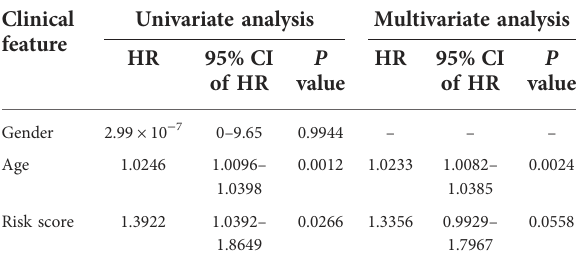
TABLE 4 Univariate and multivariate Cox regression analyses for each clinical feature (ICGC cohort). Clinical